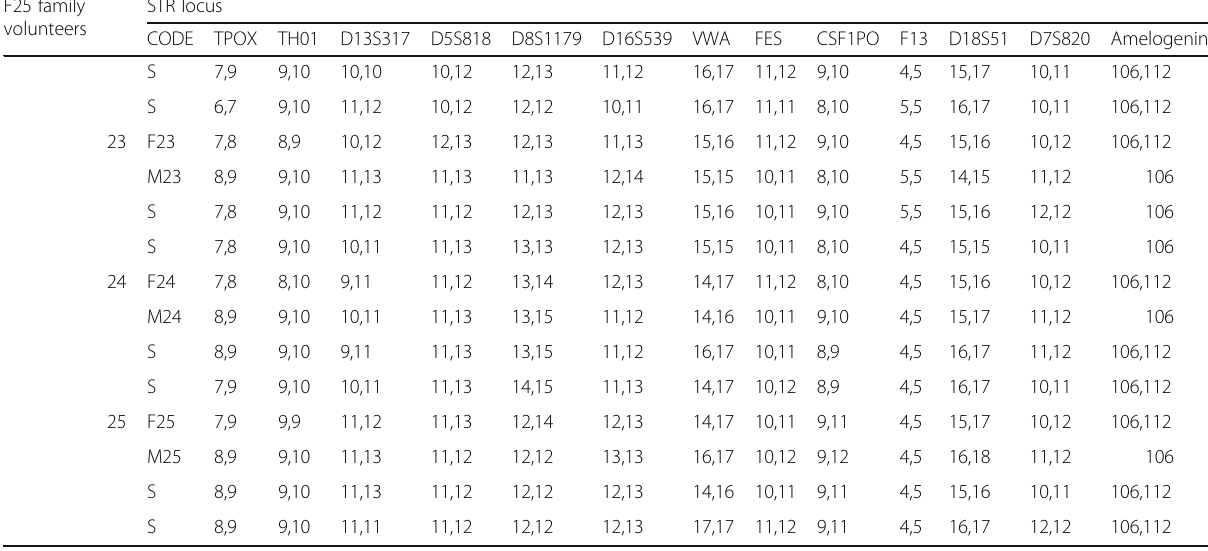
Table 1 Autosomal STR allelic genotype and amelogenin of the 25 full sibling pairs (Continued) F25 family STR volunteers